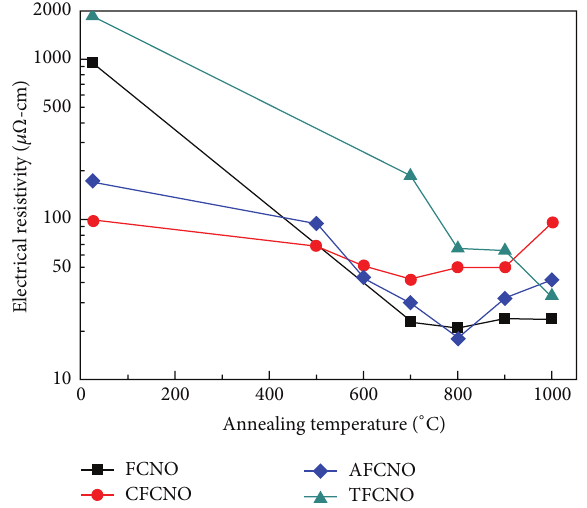
Figure 5: Plot of the resistivity of the thin films versus annealing temperature. The annealing times were all 30 min.